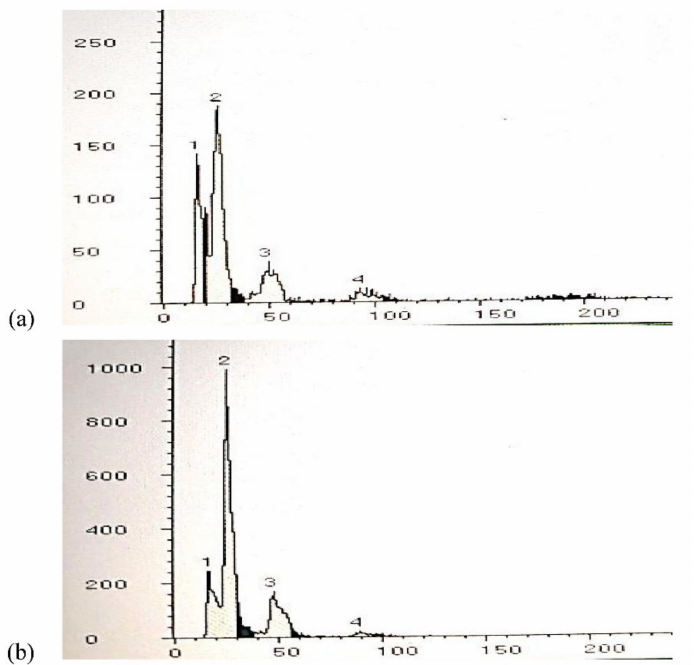
Figure 5. Flow cytometry analysis. ( a ) mother plant; ( b ) in vitro regenerated plants of L.